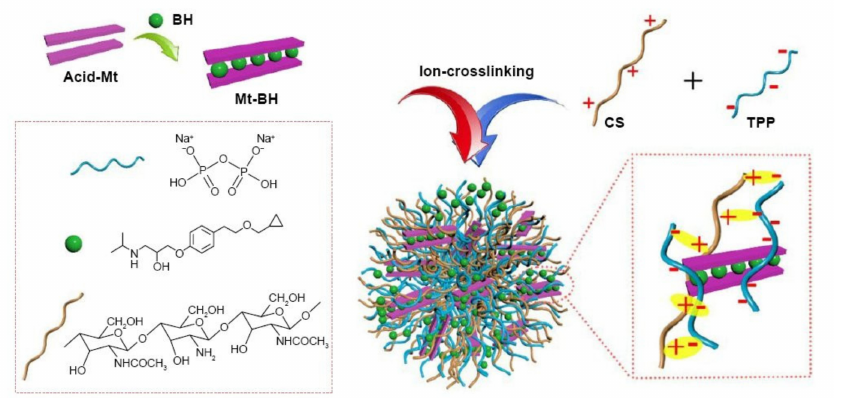
Figure 16. Schematic of the preparation process of betaxolol hydrochloride-Mnt/CS NPs using TPP as crosslinking agent [118]. Reproduced with permission from Dove Medical Press Limited